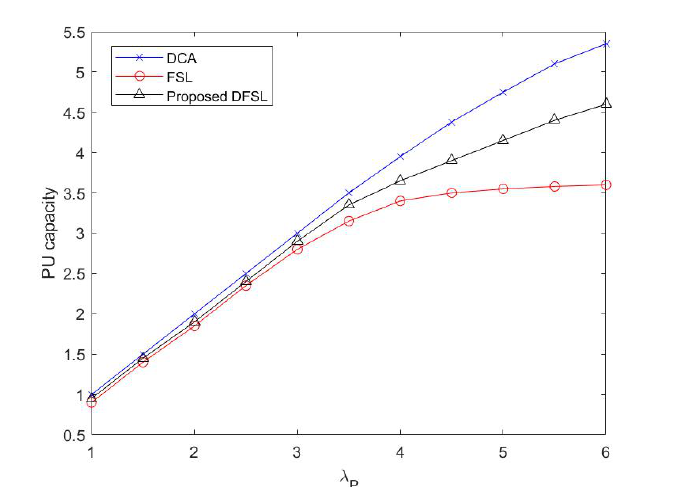
Figure 9. PU network capacity versus λ P .